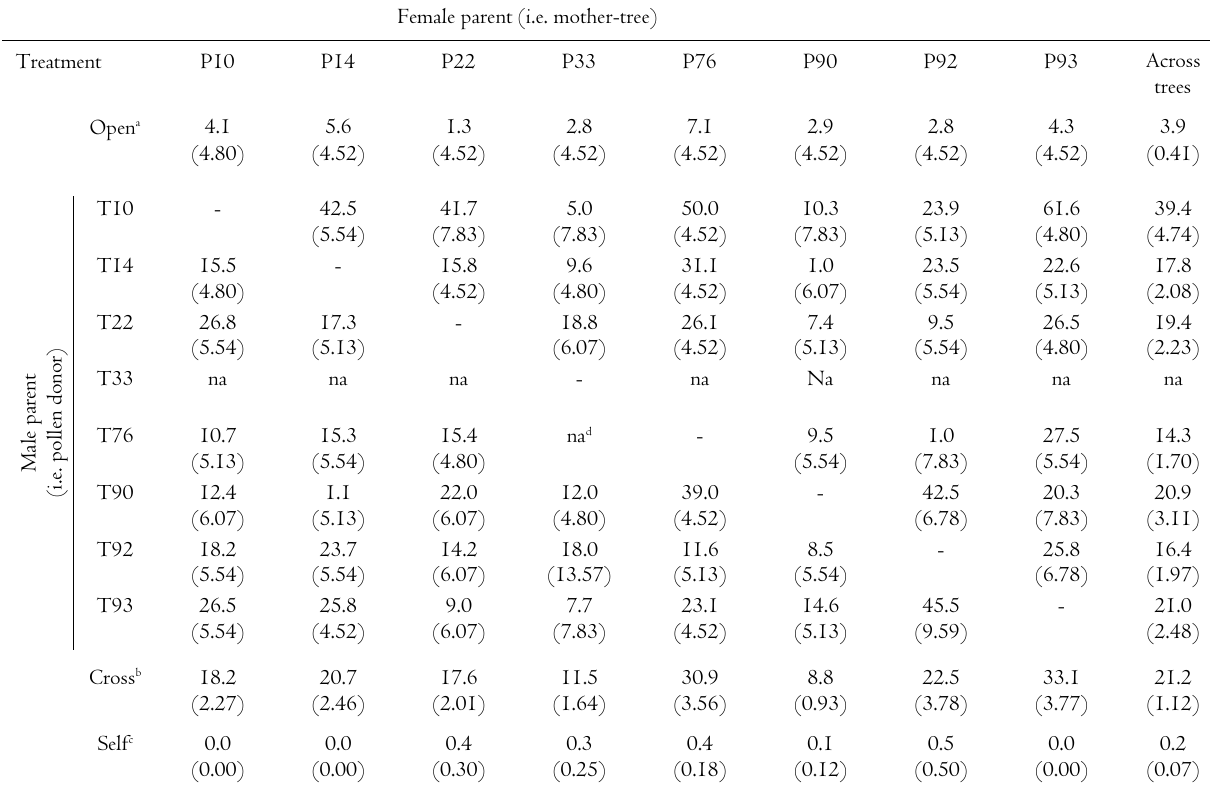
T ABLE 1. Mean number (± SE) of immature pods per hermaphroditic capitulum (i.e. small pods before maturation) of Parkia biglobosa (incl. capitula without pods). Self-pollination (grey colour) is shown in the last row. Tree P33 did not give pollen to the other